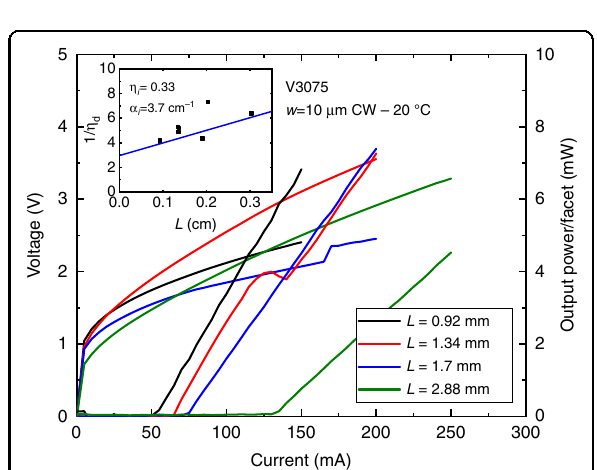
Fig. 9 L – I – V curves in CW at RT for various GaSb DLs grown on a MOVPE GaSb-on-GaAs-on Si template. The inset shows the evolution of the inverse of the external quantum ef fi ciency as function of the cavity length. Adapted with permission from ref. 107 . © Optical Society of